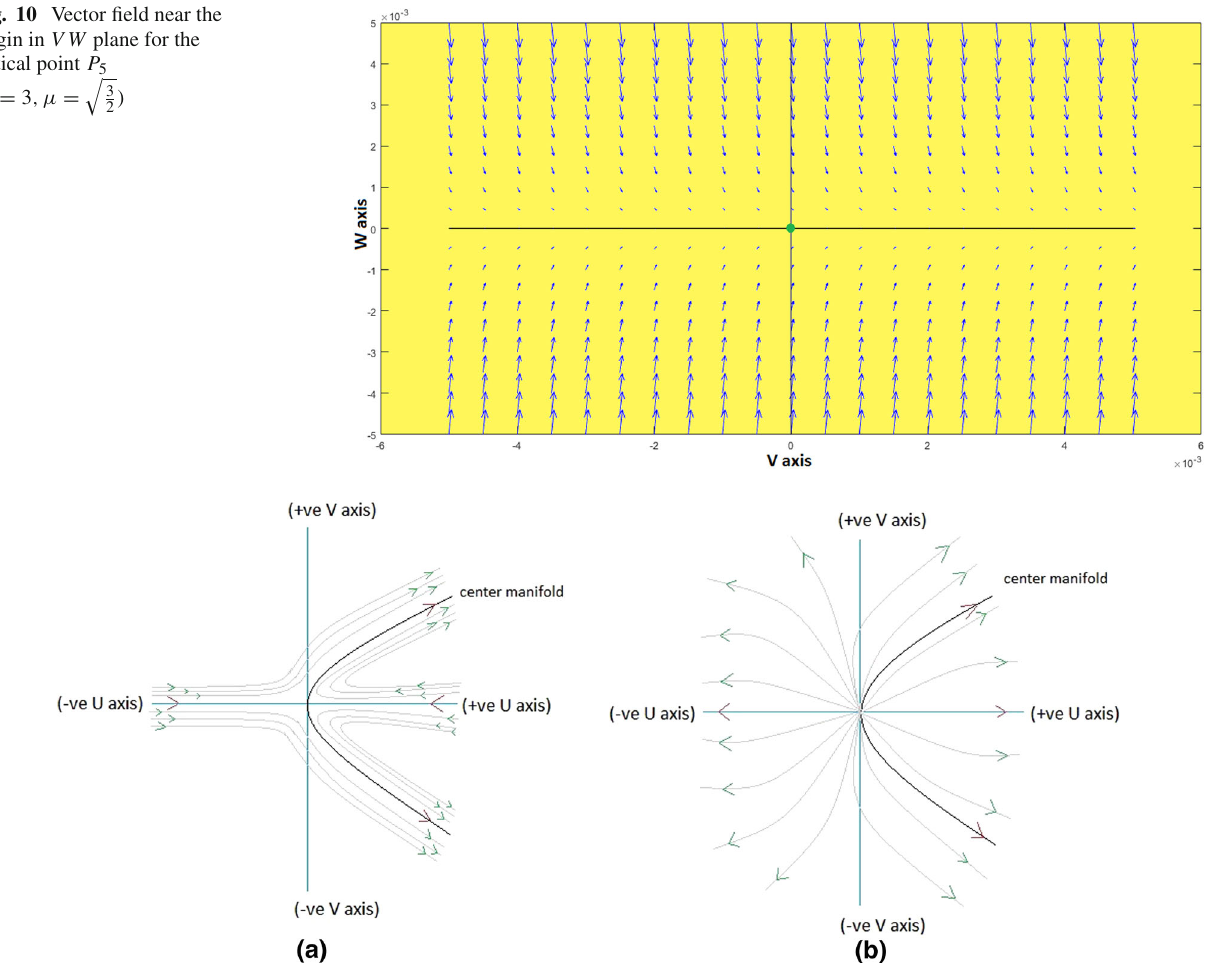
Fig. 10 Vector field near the origin in V W plane for the